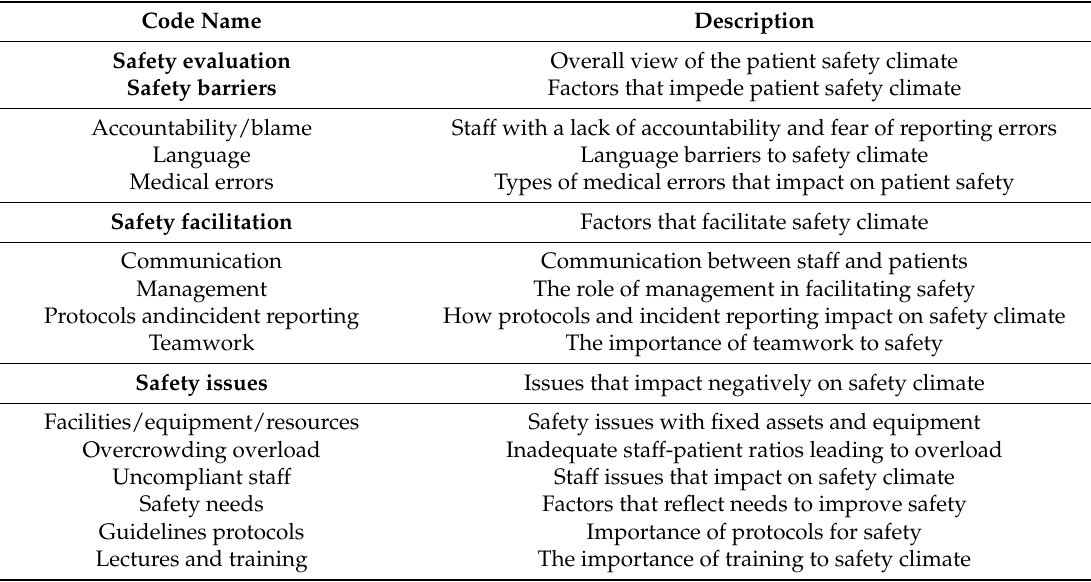
Table 1. Themes and subthemes developed from analysis of interview